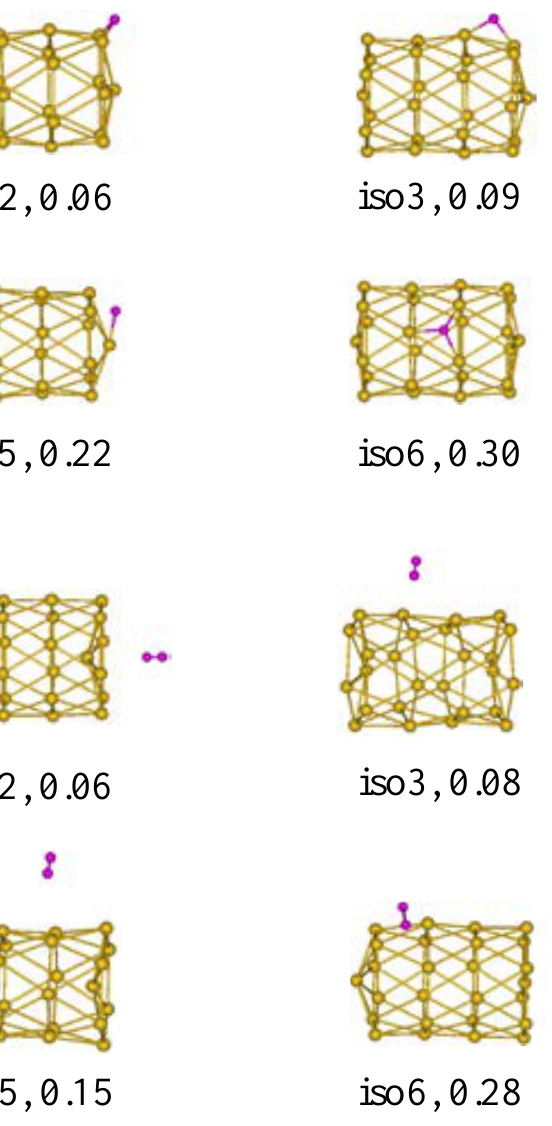
- H and ( b ) Au - H . Au, yellow; H, pink. 26 26 2